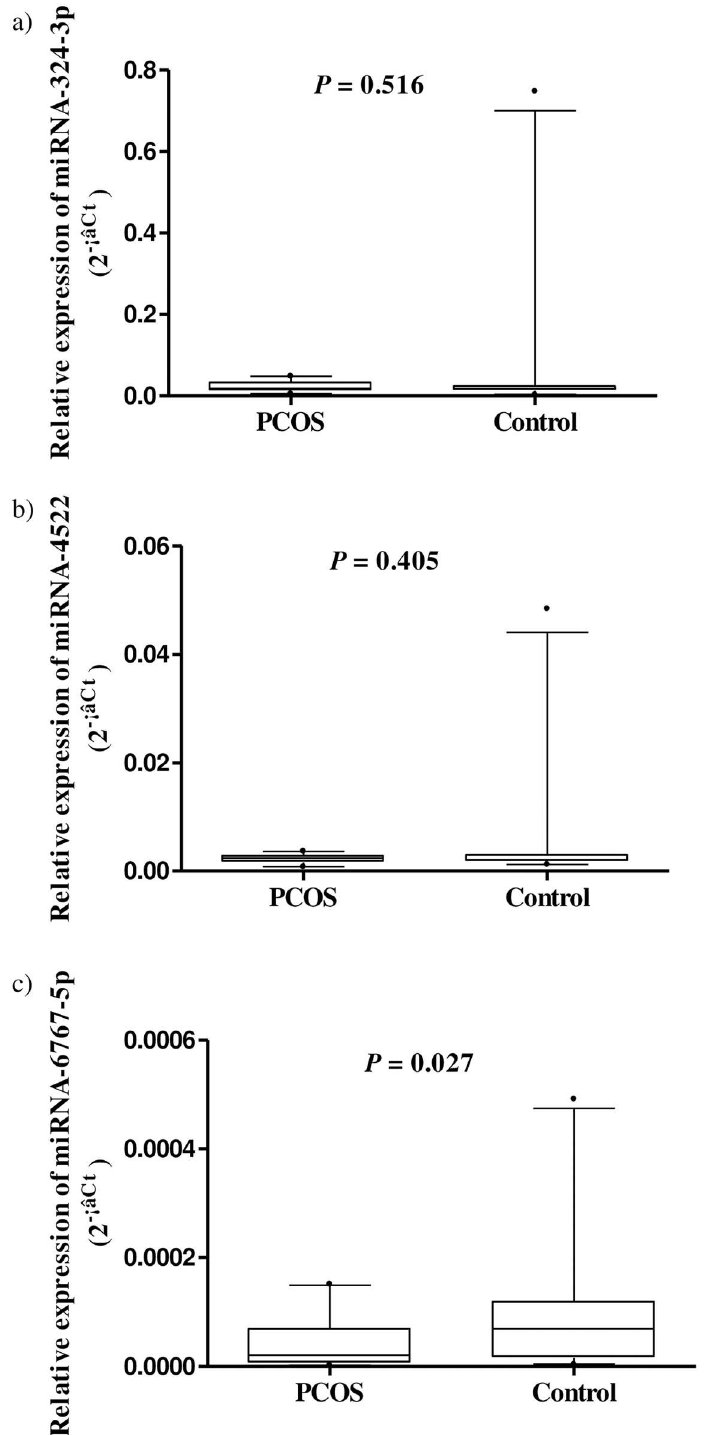
Fig 1. A boxplot for the relative expression of serum miRNAs in women with PCOS and control subjects from the quantitative real-time polymerase chain reaction analysis. (a-c) For each miRNA, the line insidethe box is the median. The top and bottom lines of the box are the first and third quartiles, respectively. The top and bottom whiskers are the 5 th and 95 th percentiles, respectively. Any data beyond these whiskers were shown as cycles. miRNA, microRNA; PCOS, polycystic ovary syndrome; Ct, the threshold